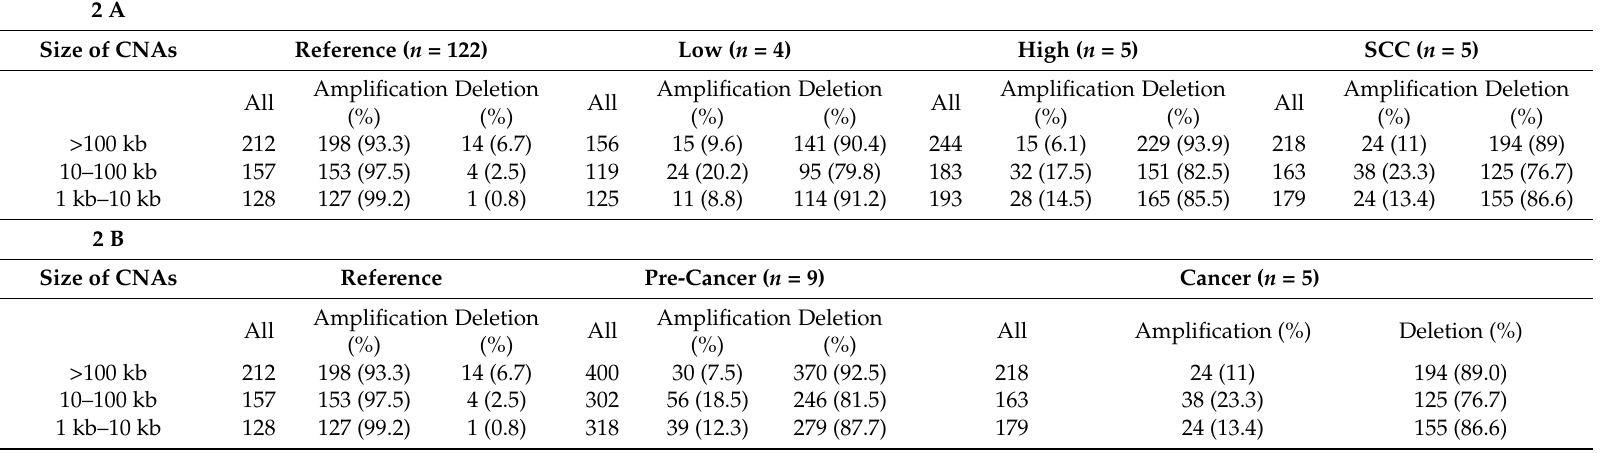
Table 2. Copy number alteration (CNA) burden (deletion and amplification) among different diagnostic